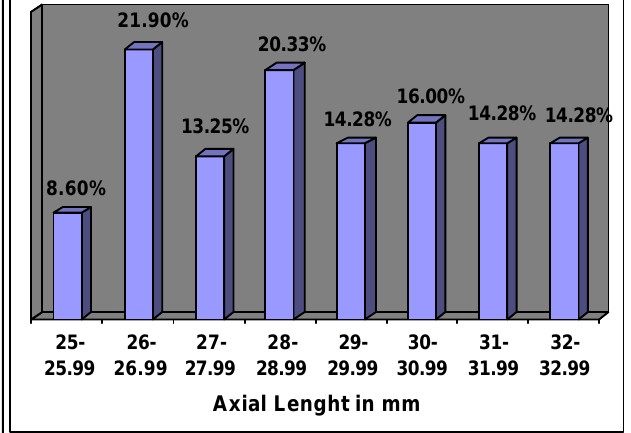
Fig. 3 : Prevalence of lattice degeneration by S